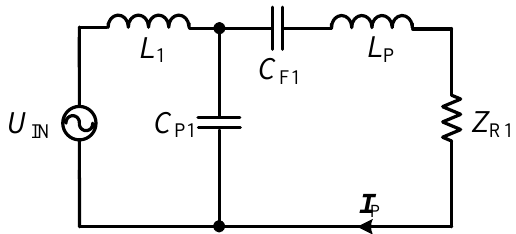
Figure 4. Primary side circuit diagram of the DS-LCC topology with reflected impedance.